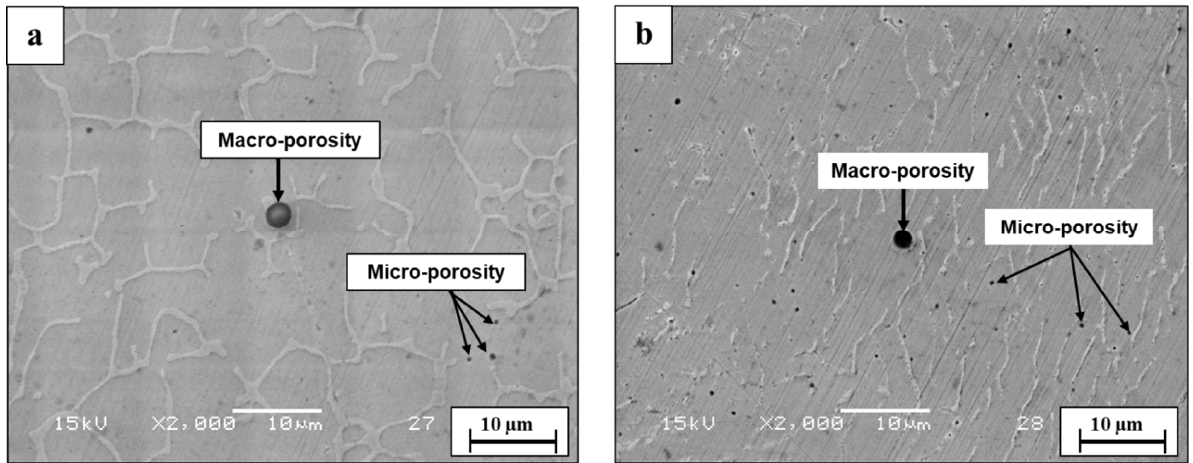
Figure 5. Printing defects in WLAM 316L samples in the form of microporosity and macroporosity. ( a ) XY plane; ( b ) XZ plane.